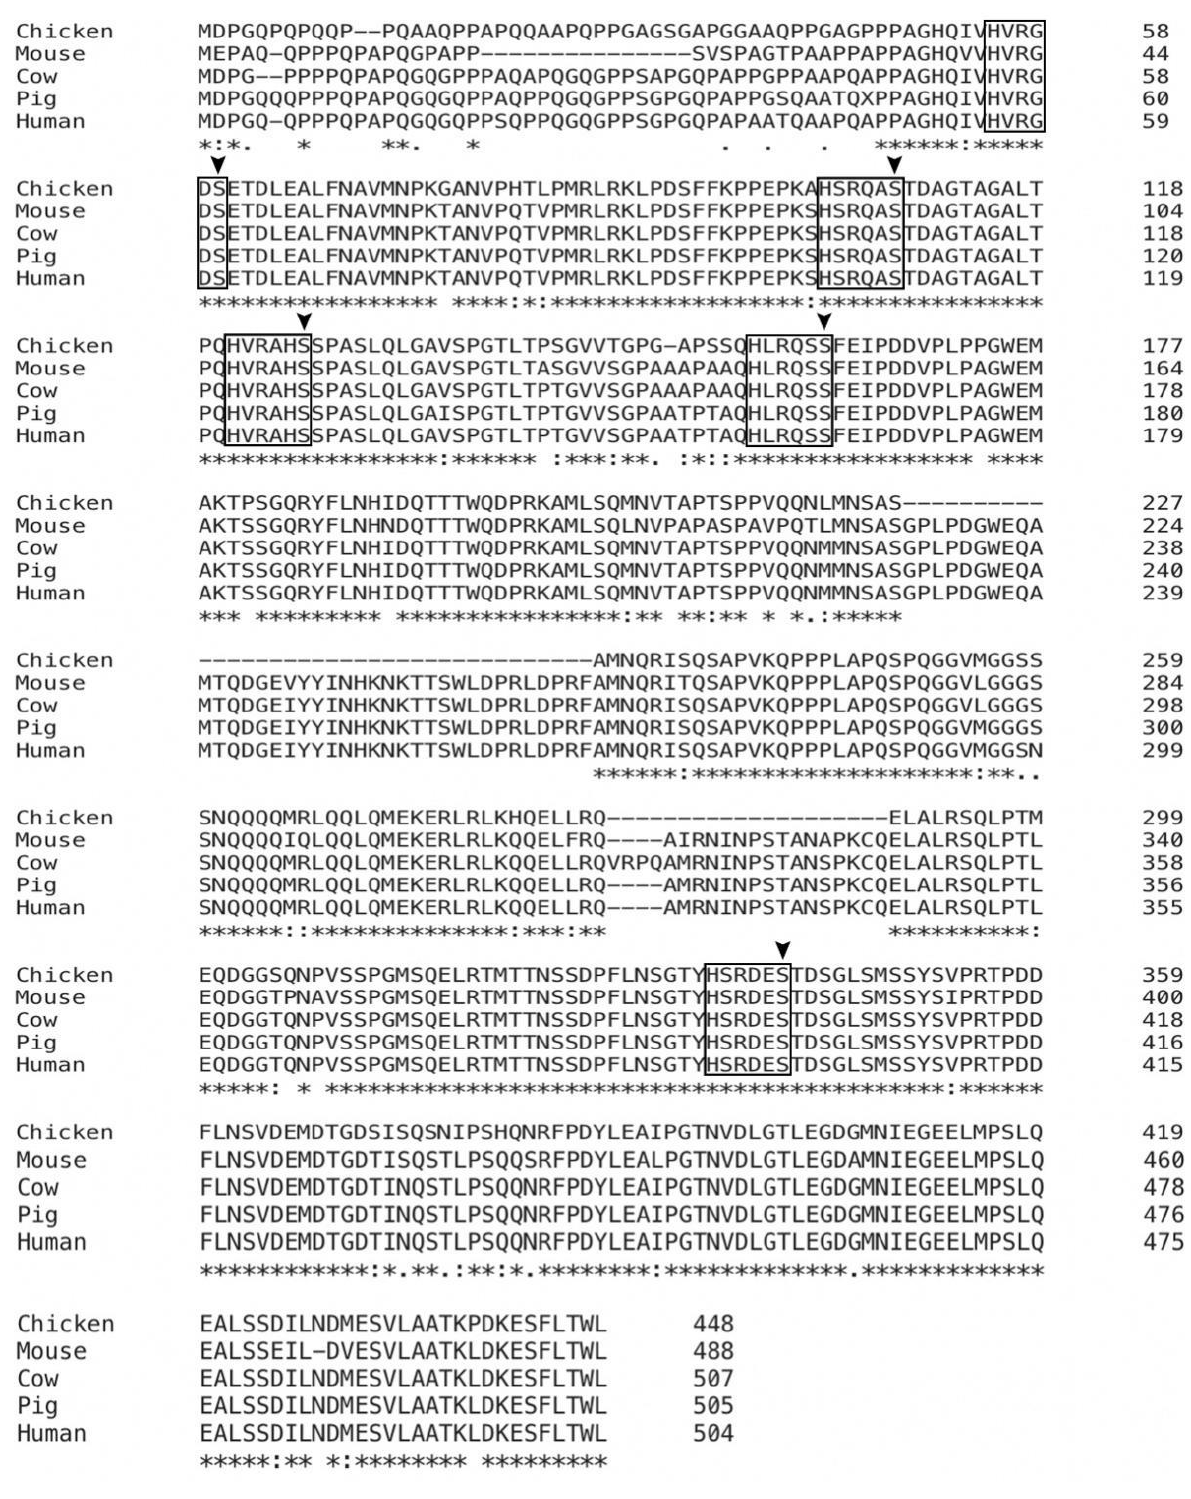
Figure 6. Alignment analysis of YAP proteins among different species. Schematic representation of the YAP protein sequences from pig and other species. The sequences enclosed by black frames indicate five conserved phosphorylation motifs HxRxxS (H: histidine, R: Arginine, S: serine) of YAP protein, and key serines are indicated by arrowheads.